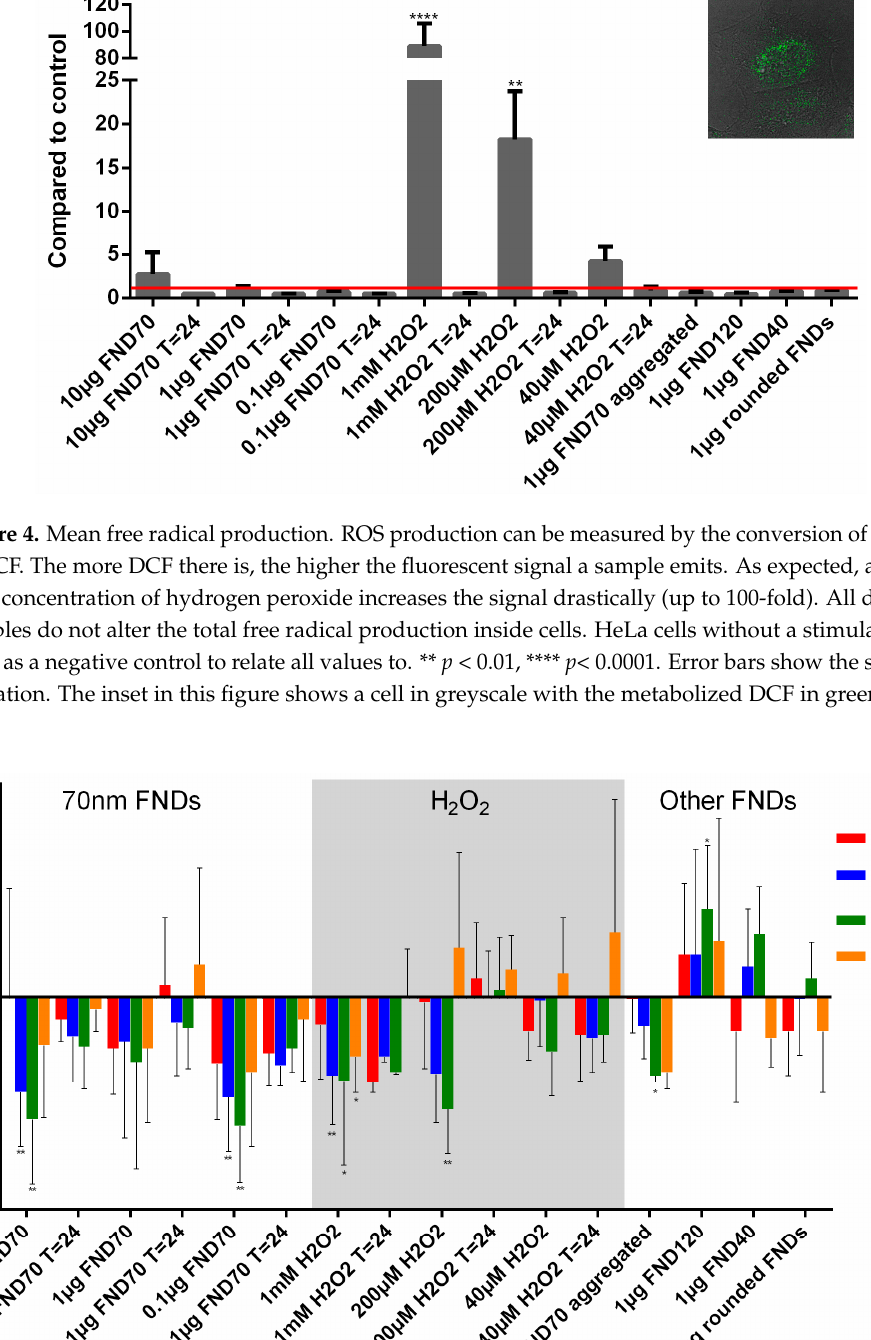
Figure 5. Relative expression of oxidative stress-related genes. The relative expression of four different genes as a response to the uptake of diamonds or the presence of H 2 O 2 has been analysed using quantitative PCR. The control is set as zero, the increase or decrease of the genetic expression is showed for all samples. Glutathion reductase and superoxide dismutase differed most often significantly from the control. * p < 0.05, ** p < 0.01. Error bars show standard deviation. Values are averages out of three independent qPCR runs that were performed in triplicate.